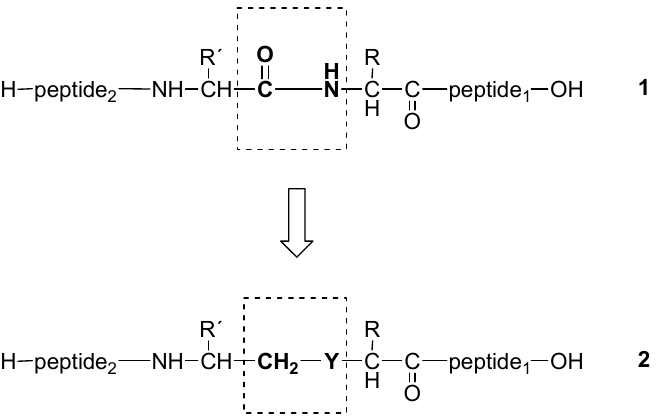
= CH 2 (a), NH (b), O (c) and S